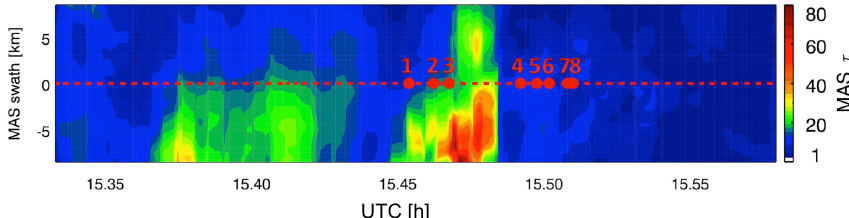
Figure 1. Cloud optical thickness from MAS along an ER-2 leg from 17 July 2007 (length: 192km, swath: 17.5km), re-gridded to a horizontal resolution of 500mm. The red dashed line indicates the ER-2 flight track in the center of the MAS swath. Results of net horizontal photon transport for the eight highlighted pixels are shown in Table 1 and Fig.